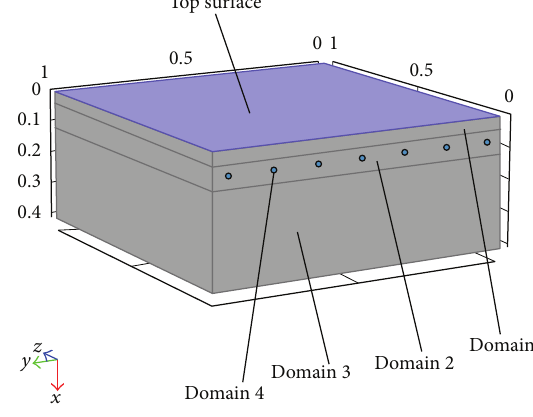
Figure 5: ASC model in